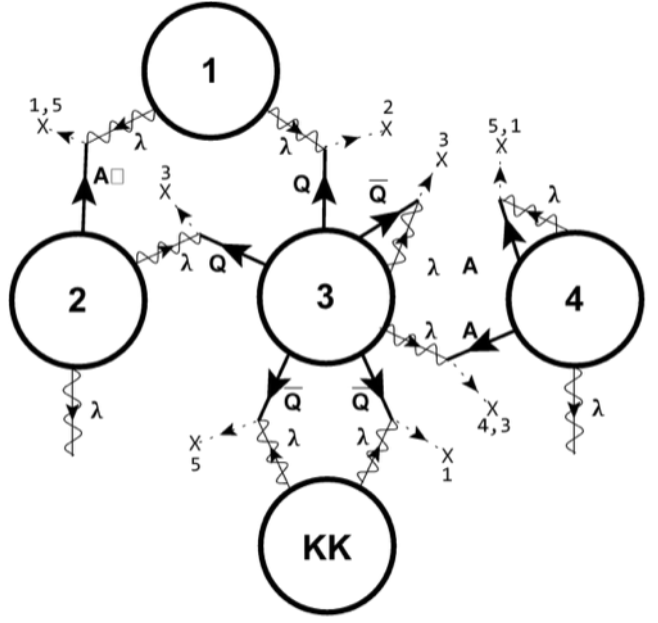
Figure 14: A sketch of multi-monopole composite with + 2 + 3 when ≫ B M ≫ B are large. The gauge group is completely broken. Only one of the “res- 2 1 onance" diagrams is shown. The anti-symmetric and squark VEVs, (C.3) and (C.4), are represented as X with their